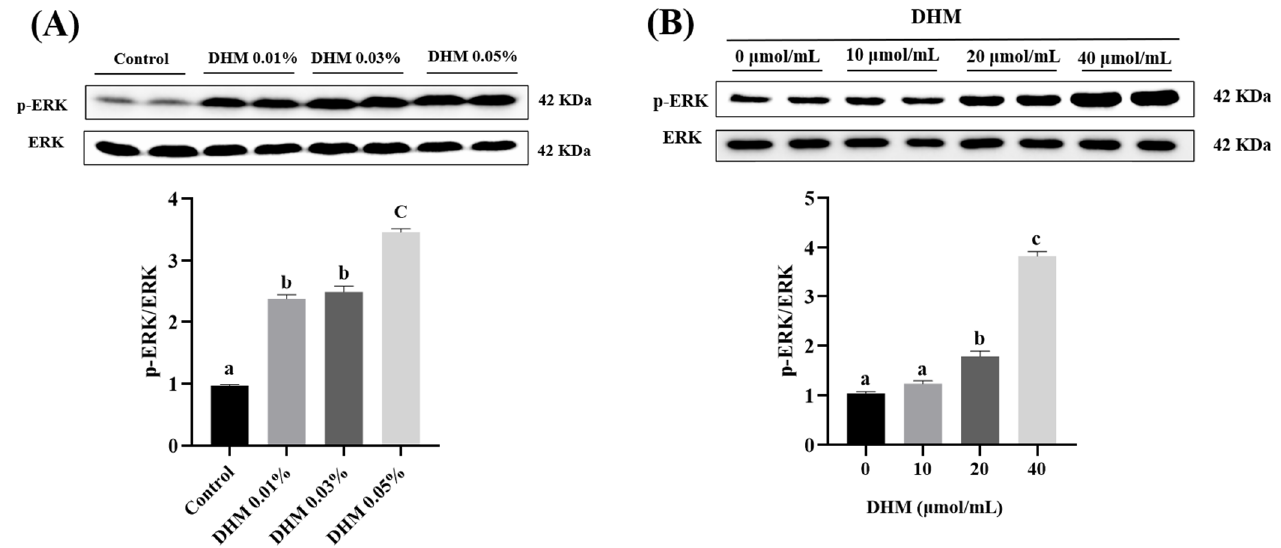
Figure 3. Effect of DHM on the protein expression of p-ERK. ( A ) The protein level of p-ERK in jejunum mucosa of growing-finishing pigs. ( B ) The protein level of p-ERK in IPEC-J2 cells. The protein expression of p-ERK was normalized to ERK. Data are expressed as the mean ± SE. Values with different superscript letters are significantly different ( p < 0.05).